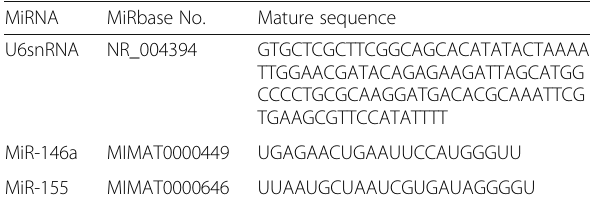
Table 1 Target MiRNA and endogenous control sequences